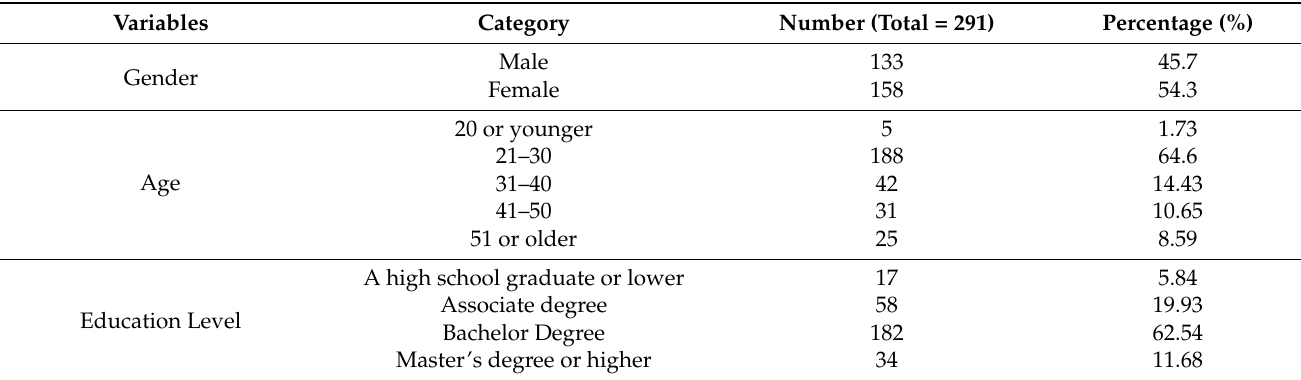
Table 1. Sample Table 1. Sample characteristics.